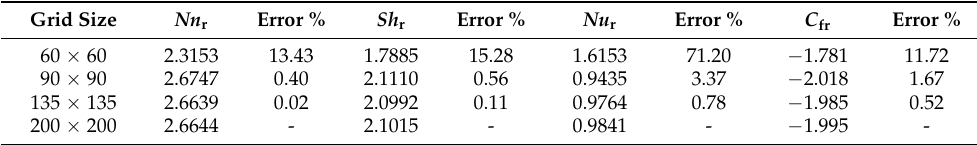
Figure 2. Comparison of the temperature and nanoparticle concentration profiles concluded by the current work and that done by Noghrehabadi et al. [4]. Table 1. Grid independence test with errors calculated with respect to the finest grid